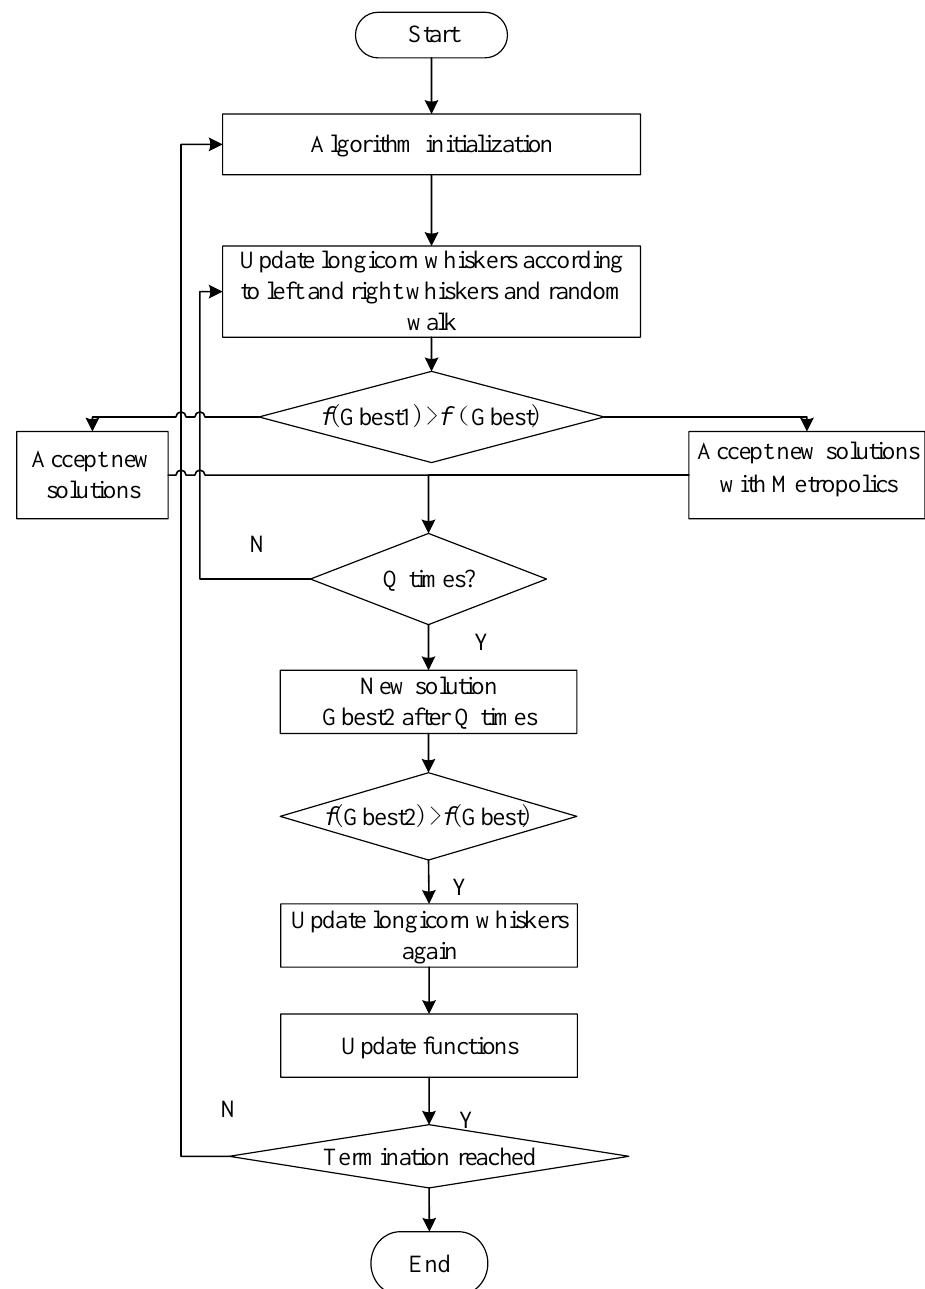
Figure 3. RWSAVSBAS algorithm flow.